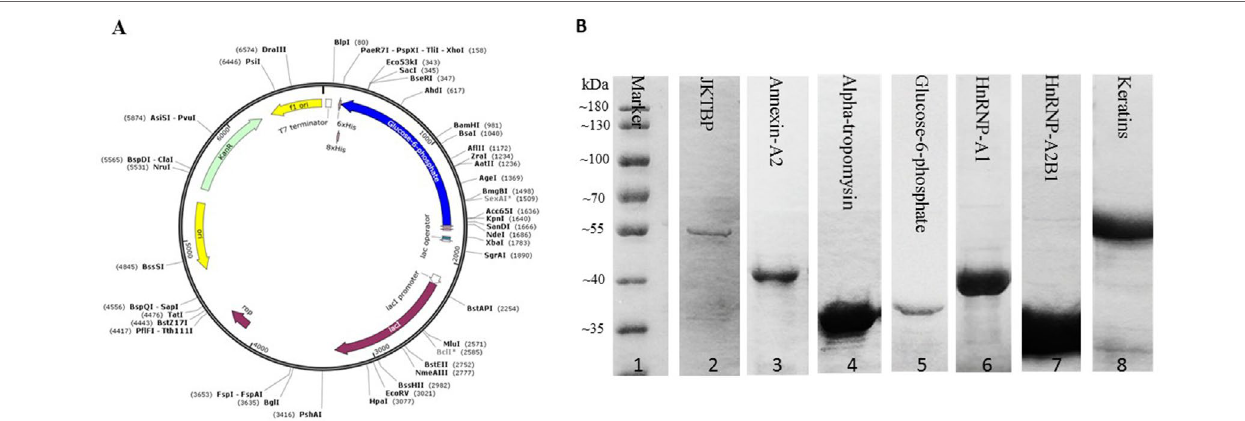
FIGURE 1 | Gene cloning, expression and purification of autoantigens for protein chip preparation. (A) Synthetic gene was cloned into NdeI/XhoI digested pET28a. (B) Purified proteins were separated with 10% SDS-PAGE and then stained with coomassie brilliant blue. Lane 1: protein marker, Lane 2: JKTBP, Lane 3: Annexin-A2, Lane 4: Alpha-tropomysin, Lane 5: Glucose-6 phosphat, Lane 6: Hnrnp-A1, Lane 7: Hnrnp-A2B1, Lane 8: Keratins isoform of heterogeneous nuclear ribonucleoprotein D-like = JKTBP, heterogeneous nuclear ribonucleoprotein A2B1 = HnRNP A2B1, heterogeneous nuclear ribonucleoprotein A1 = HnRNP